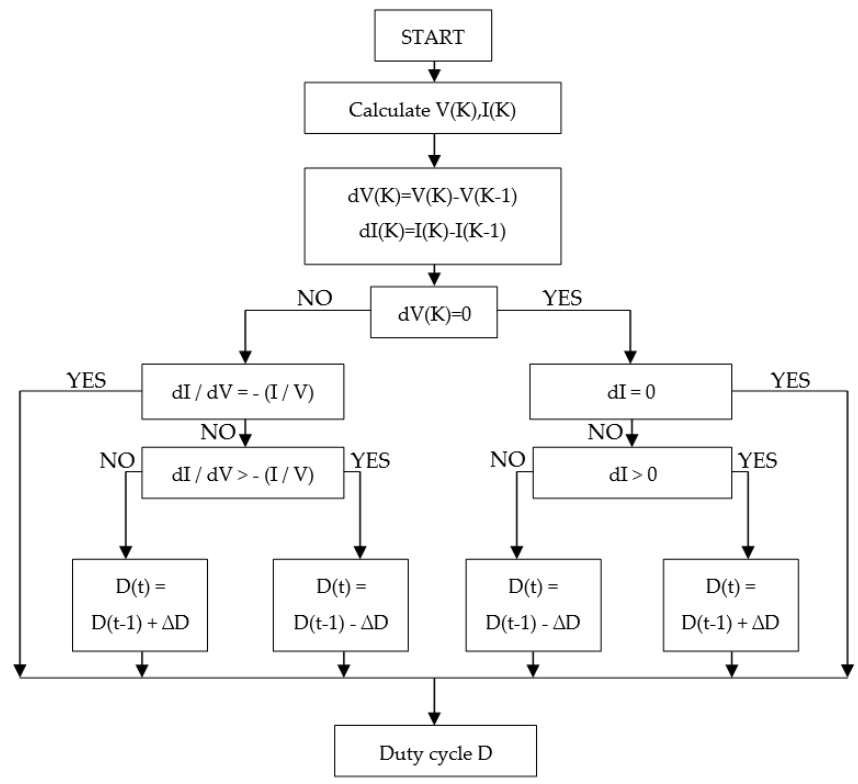
Figure 5. Flowchart of INC algorithm.